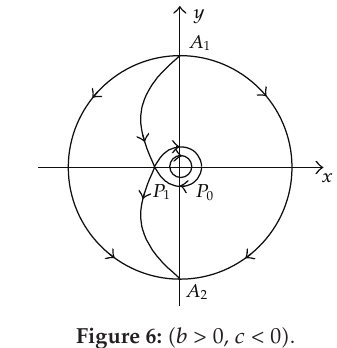
Figure 6: (cid:6) b > 0, c < 0 (cid:7) .